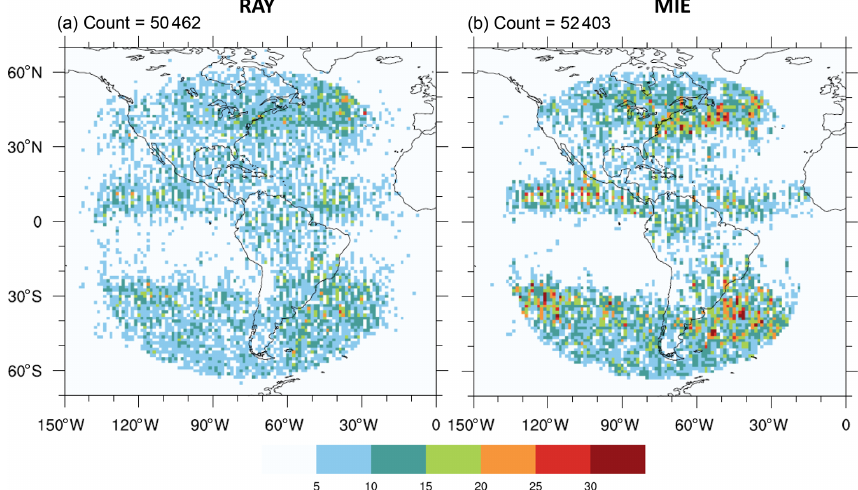
Figure 4. Number densities of quality-controlled GOES-16 AMV observations co-located with quality-controlled Aeolus (a) Rayleigh-clear (RAY) and (b) Mie-cloudy (MIE) HLOS winds. Colors indicate total number of co-located observation pairs within a grid cell at 1.25 ◦ (approximately 140km in the N–S direction) horizontal resolution. Total observation count per panel is displayed at the top left corner. This and all subsequent plots are for all co-locations with quality-controlled AMV and Aeolus winds during the study period (2 August to 16 September